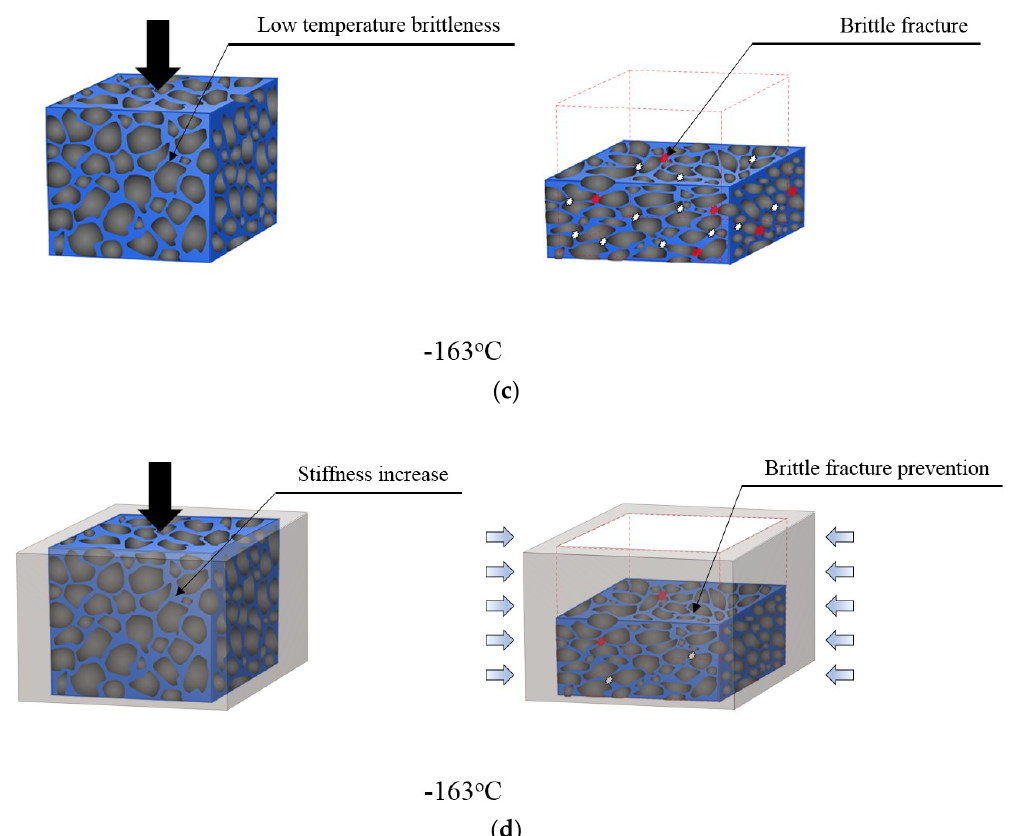
Figure 14. Cell structures inside the rigid PUF specimen against the compressive force depending on the environmental condition variables of restraint and temperature. ( a ) non-restraint at 25 °C; ( b ) restraint at 25 °C; ( c ) non-restraint at −163 °C; ( d ) restraint at −163 °C